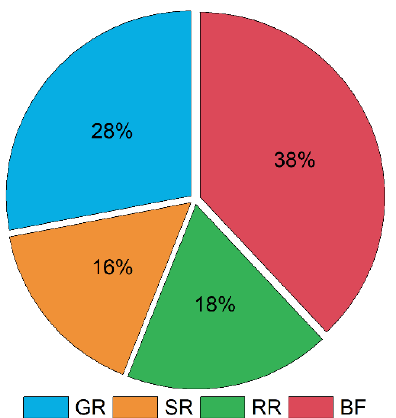
Figure 12. Mean annual contributions of runoff components to the total runoff.